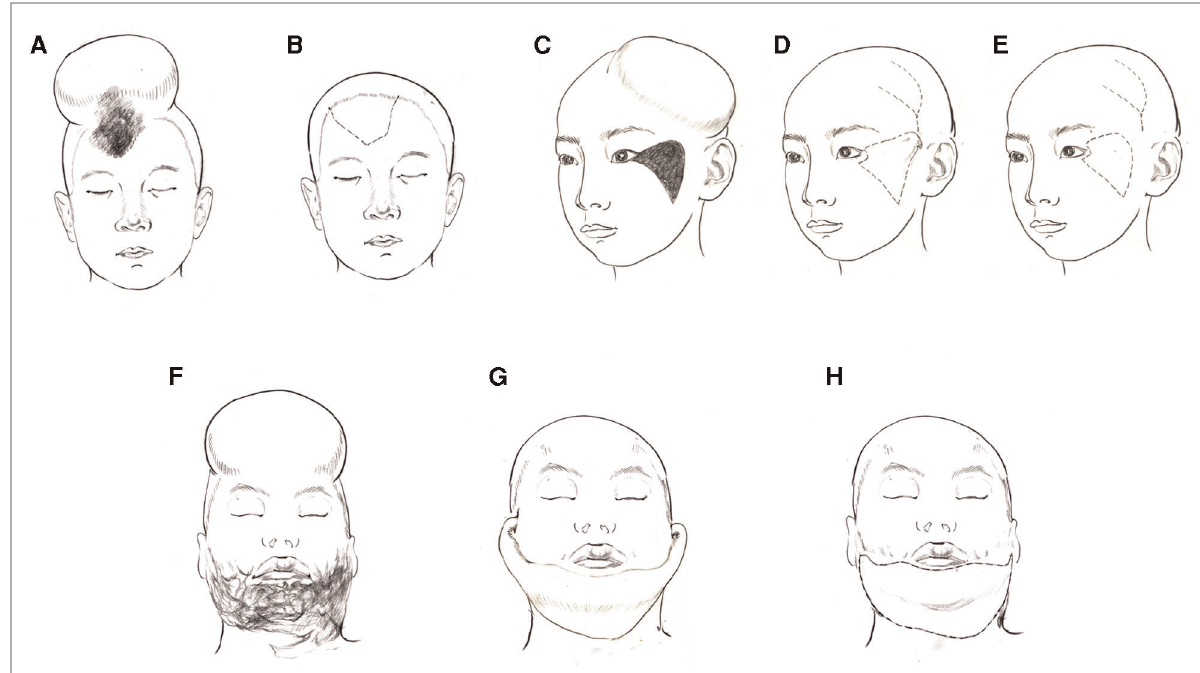
FIGURE 1 Schematic diagram of the operation method according to the location of the lesions. ( A,B ), The expanded scalp fl aps were transferred to the defect via fl ap advancement to treat forehead defects. ( C – E ), the expanded scalp fl aps were raised and transferred to reconstruct the cheek or upper lips pedicled by the unilateral super fi cial temporal artery. ( F – H ), the expanded scalp fl aps were raised and transferred pedicled by both the super fi cial temporal vessels to treat lesions on the lower lip and